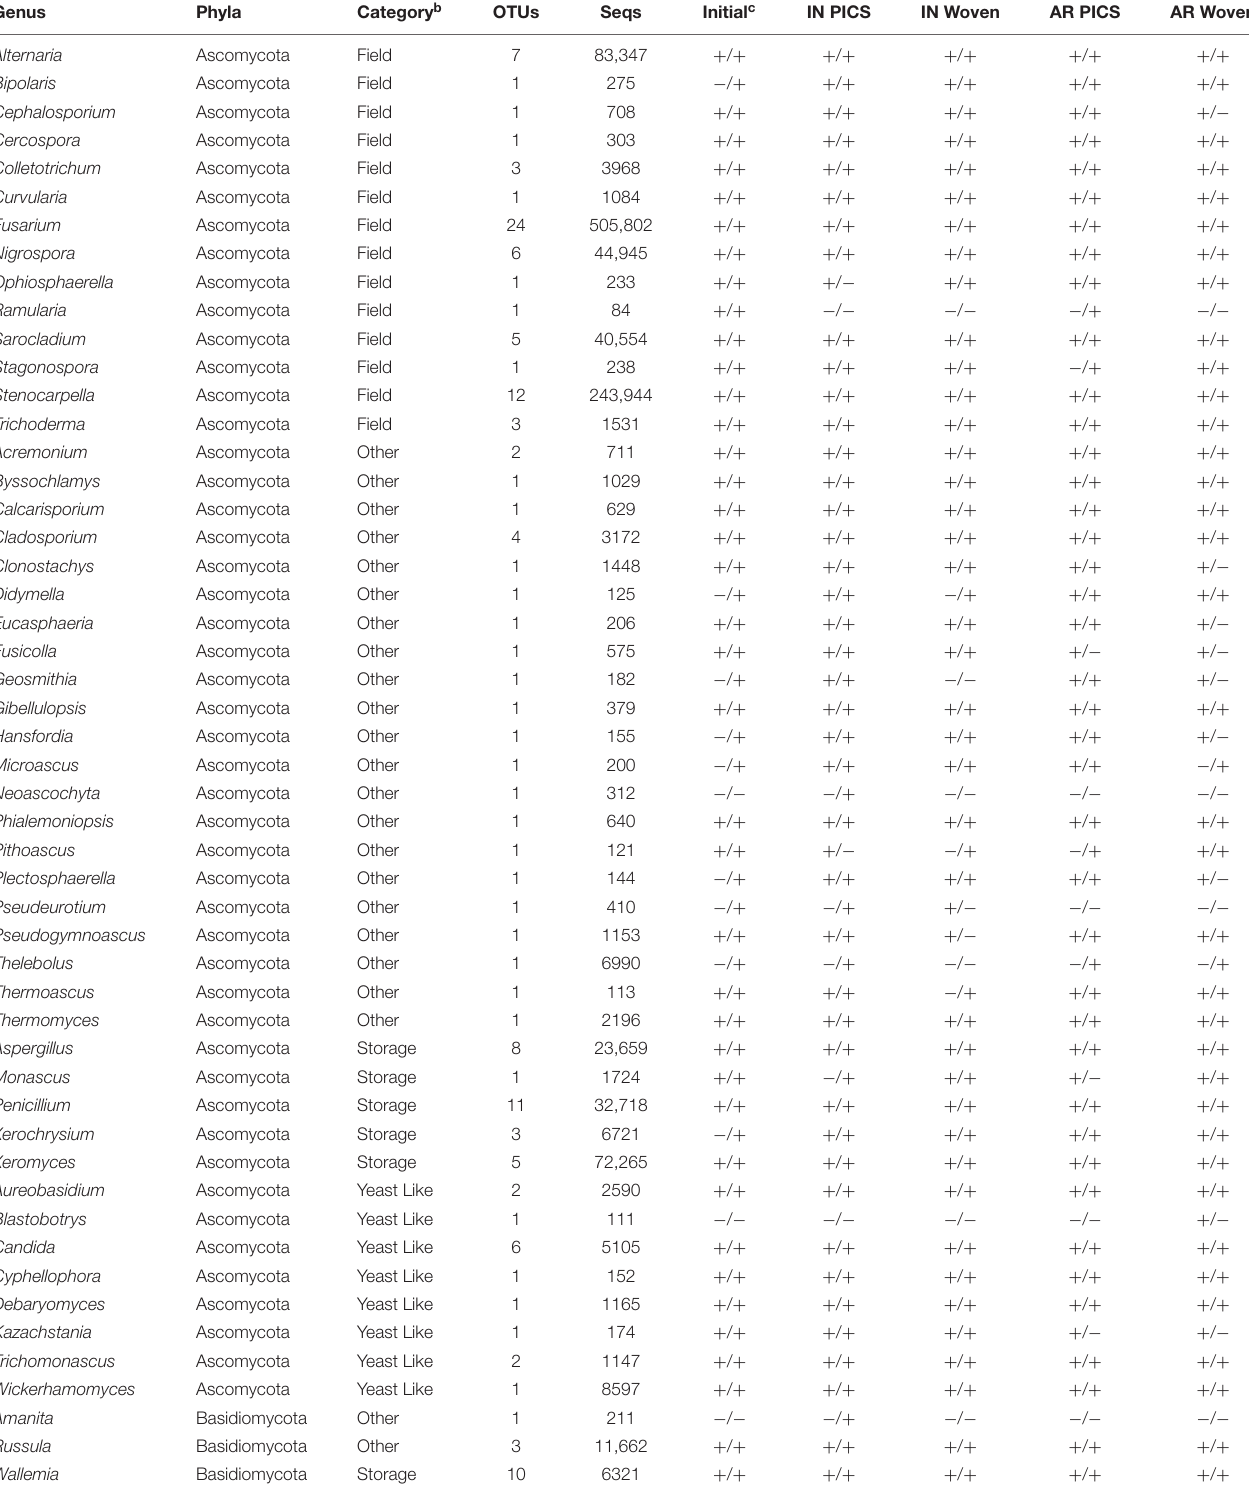
TABLE 3 | Genera identified from OTUs in maize kernels stored in Indiana (IN) and Arkansas (AR) after 3 months a .